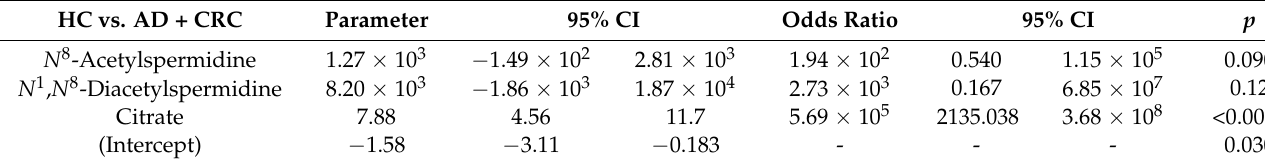
Table 4. MLR model to discriminate CRC + AD from HC.